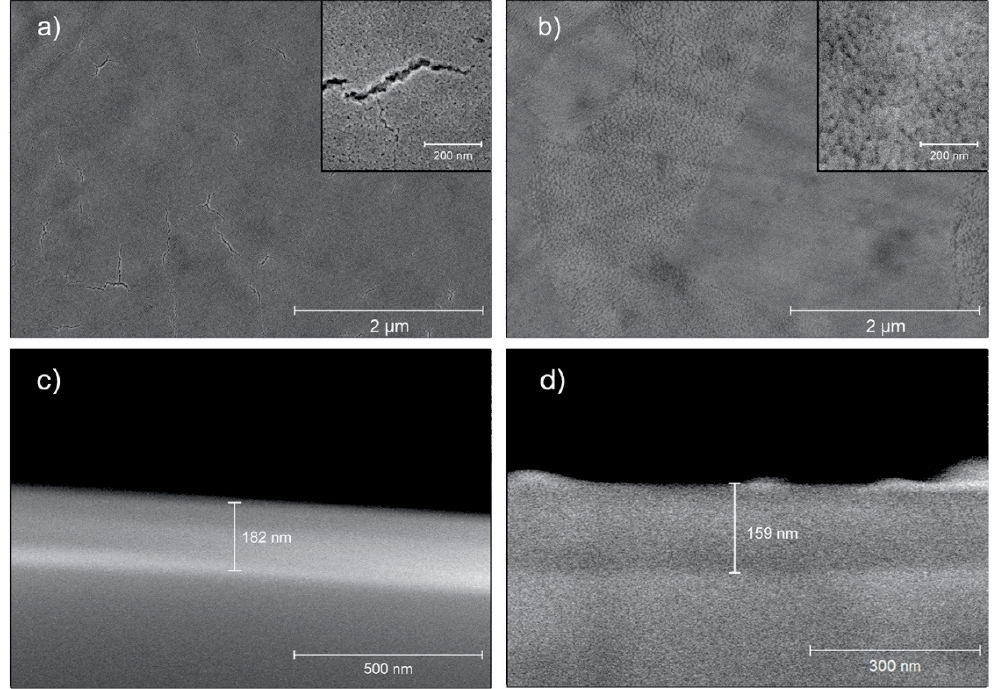
Figure 2. Scanning electron microscope (SEM) pictures of nanocoated surfaces: ( a ) Ti-3YSZ; ( b ) Ti-LS2; ( c ) cross-section of 3YSZ coating; ( d ) cross-section of LS2 coating.